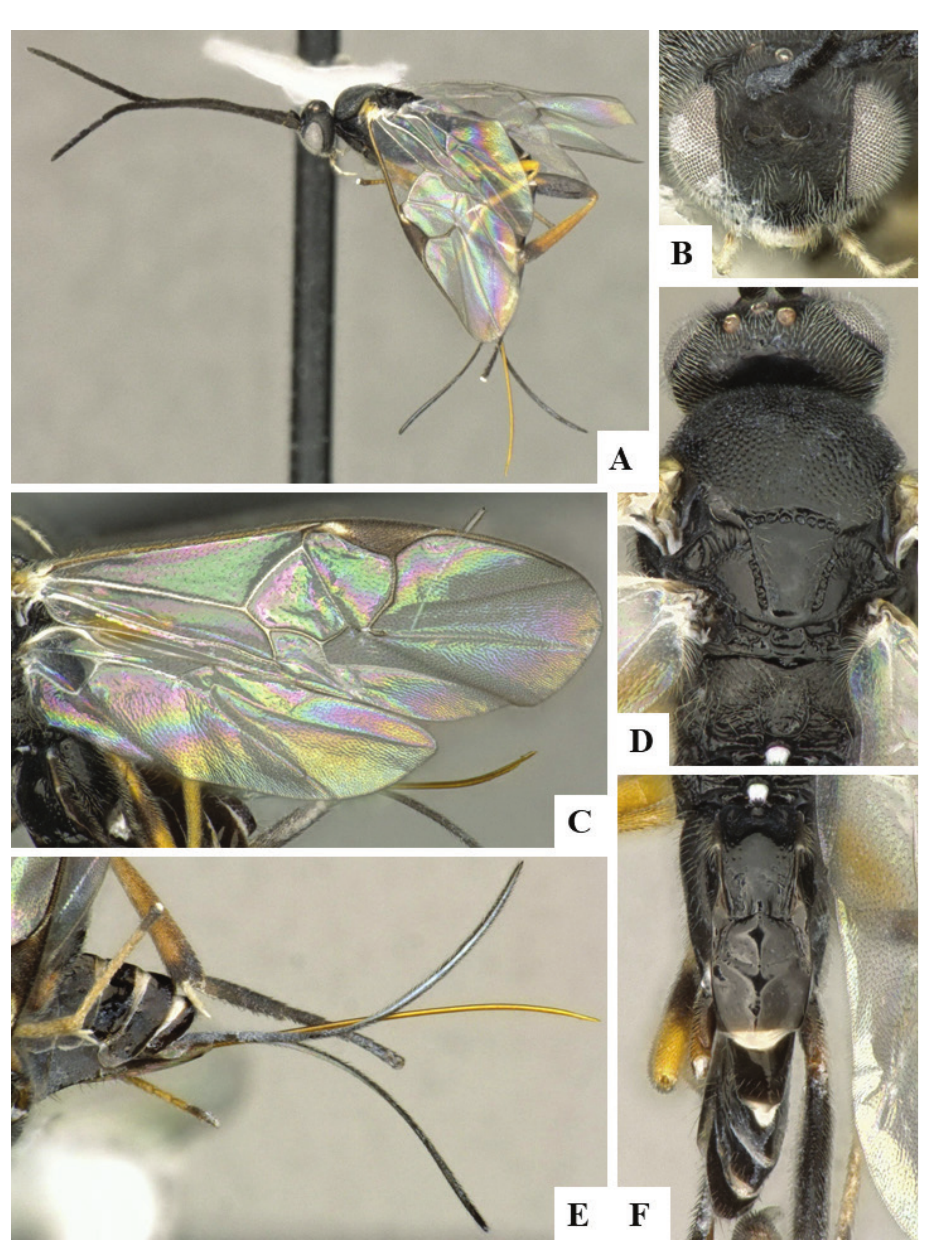
Figure 4. A–F Dolichogenidea genuarnunezi sp. n., holotype. A habitus, lateral B head, frontal C wings D head and mesosoma, dorsal E metasoma (partially), lateral F metasoma,